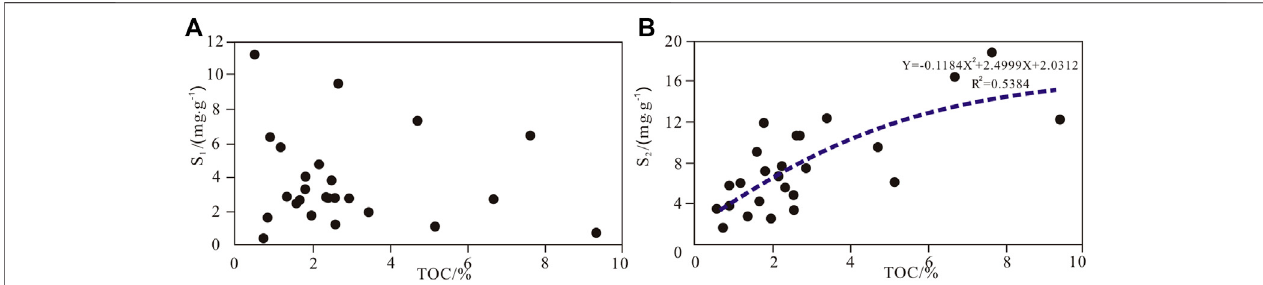
FIGURE 4 | Plots showing the relationship between TOC and pyrolysis parameters (A) TOC versus S 1 ; (B) TOC versus S 2 .